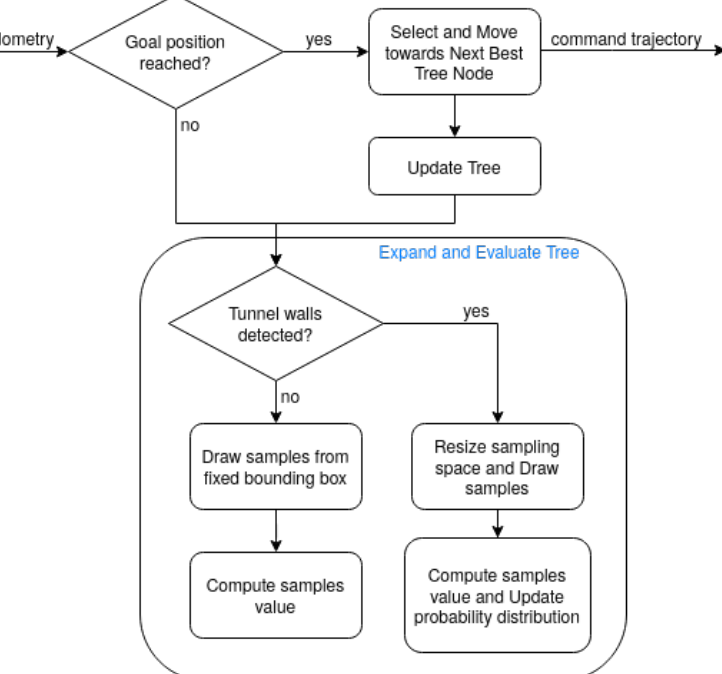
Figure 5. Inspection path planning overview. The tree is continuously expanded and evaluated until the robot reaches its current goal position. Then, the trajectory to the next best tree node adjacent to the robot’s position is commanded, and the tree is updated. All modules can access and are aware of the state of the